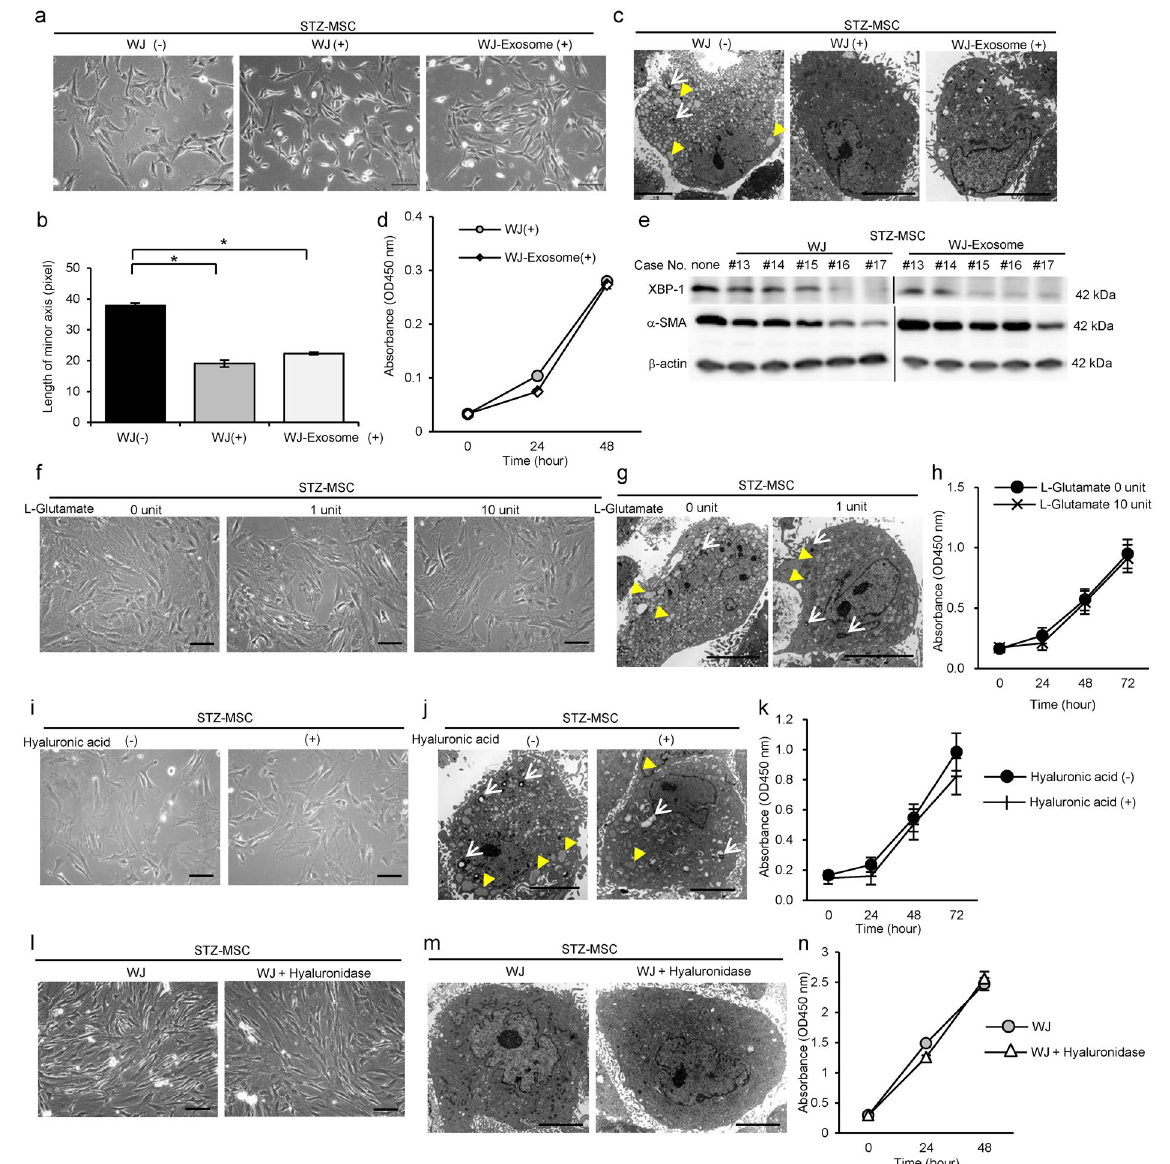
Figure 7. Activating effects of exosomes isolated from WJs (WJ-Exosome), L-Glutamate and hyaluronic acid compared with complete WJs for STZ-MSC. ( a ) Phase contrast images of STZ-MSC cultured with complete WJs or WJ-Exosome. Bar: 100 µ m. ( b ) The average length of minor axis of cells in phase contrast images. All cells in five panels of each STZ-MSC were measured. N = 3, each. * P < 0.05. ( c ) TEM images of STZ-MSC. White arrows show mitochondria degenerations. Yellow arrowheads show abnormal dilation of the ER. Bar: 5 µ m. ( d ) MTT proliferation assays of STZ-MSC. Absorbance was measured 0, 24 and 48 hours after the MTT addition. N = 5, each. ( e ) Western blot analysis of STZ-MSC cultured with complete WJs (lots #13–17) or WJ- exosome (same lots) using anti- α -SMA and β -actin antibodies. The cropped images of immunoblots displayed in the figure and the full-length blots were shown in Supplementary Fig. S18. ( f ) Phase contrast images of STZ- MSC cultured with L-Glutamate. One unit of L-Glutamate indicates the same amount of L-Glutamate included in complete WJs which are added to STZ-MSC. Bar: 100 µ m. ( g ) TEM images of STZ-MSC cultured with L-Glutamate. White arrows show mitochondria degenerations. Yellow arrowheads show abnormal dilation of the ER. Bar: 5 µ m. ( h ) MTT proliferation assays of STZ-MSC. Absorbance was measured 0, 24, 48 and 72 hours after the MTT addition. N = 5, each. ( i ) Phase contrast images of STZ-MSC cultured with hyaluronic acid. Bar: 100 µ m. ( j ) TEM images of STZ-MSC cultured with hyaluronic acid. White arrows show mitochondria degeneration. Yellow arrowheads show abnormal dilation of the ER. Bar: 5 µ m. ( k ) MTT proliferation assays of STZ-MSC. Absorbance was measured 0, 24, 48 and 72 hours after the MTT addition. N = 5, each. ( l ) Phase contrast images of STZ-MSC cultured with WJs and WJs pretreated with hyaluronidase. Bar: 100 µ m. ( m ) TEM images of STZ-MSC. Bar: 5 µ m. ( n ) MTT proliferation assays of STZ-MSC. Absorbance was measured 0, 24 and 48 hours after the MTT addition. N = 5, each. Values are expressed a mean ±